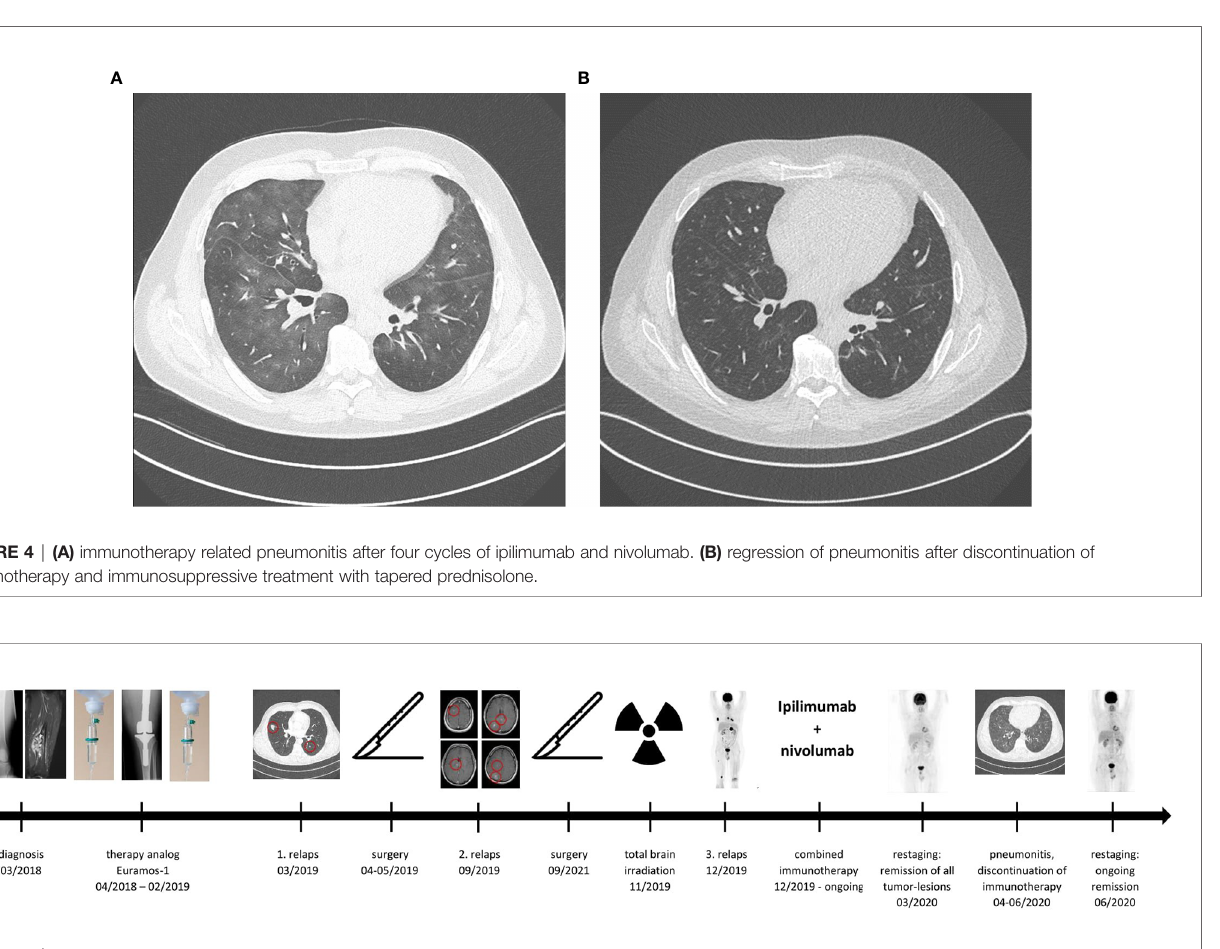
FIGURE 5 | Timeline of the patients'